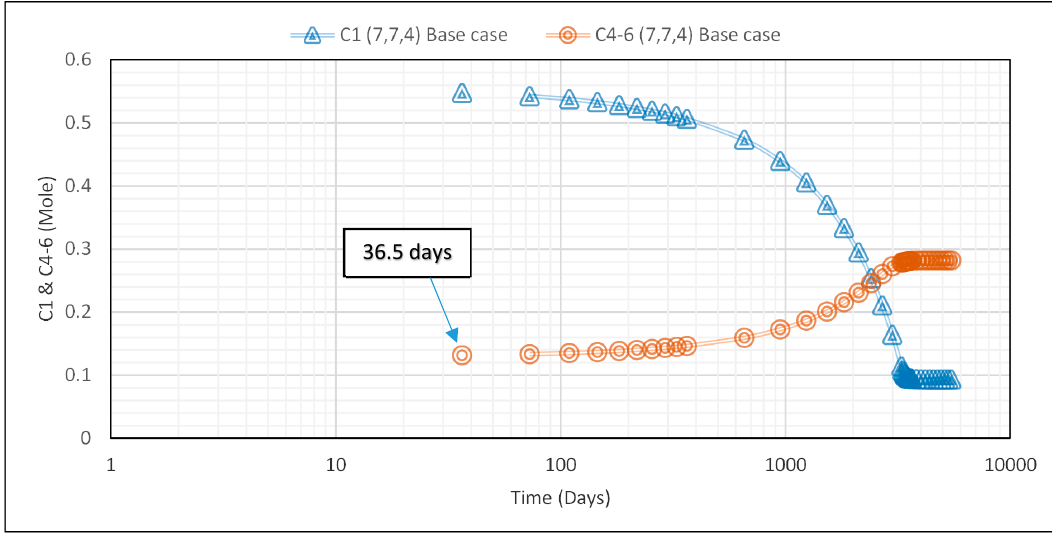
Figure 6. Composition of fluid components over time for the base case at the wellbore.